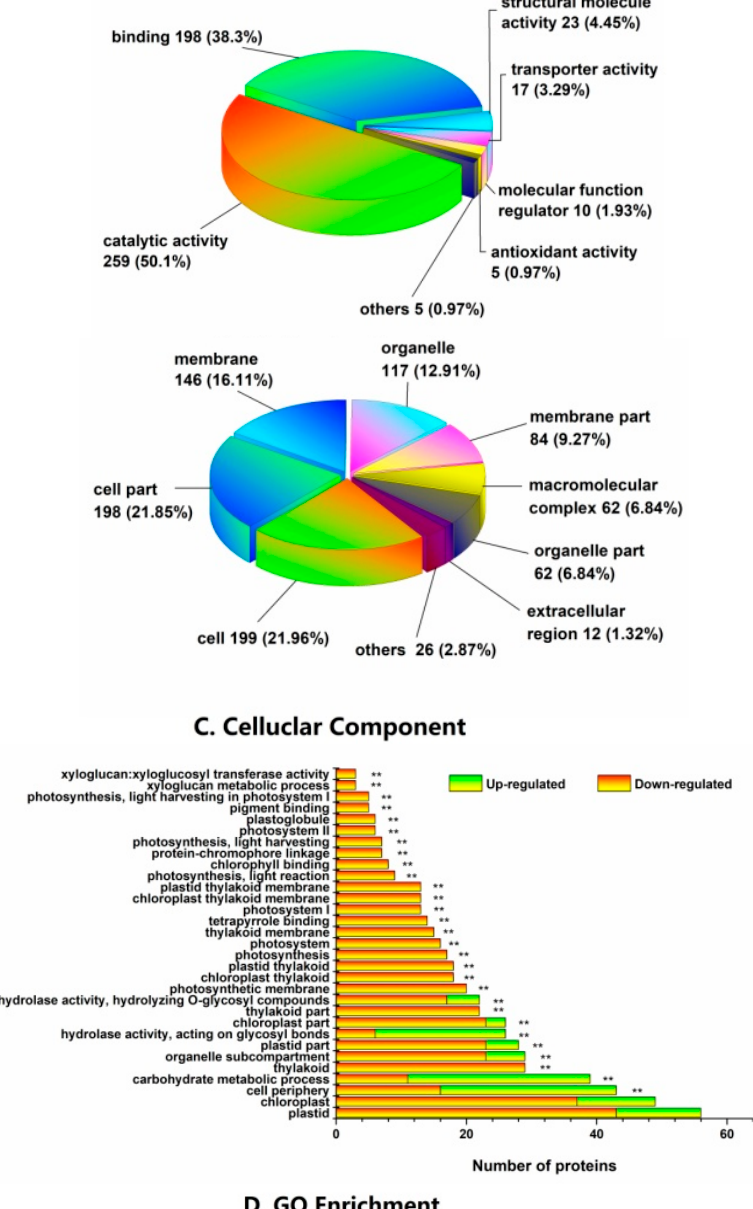
Figure 5. ClueGO and GO enrichment analysis of proteins with differential abundance: ( A ) Biological Process; ( B ) Molecular Function; ( C ) Cellular Component; and ( D ) GO enrichment. ** indicate significant difference at p < 0.01 by Tukey’s test, respectively.